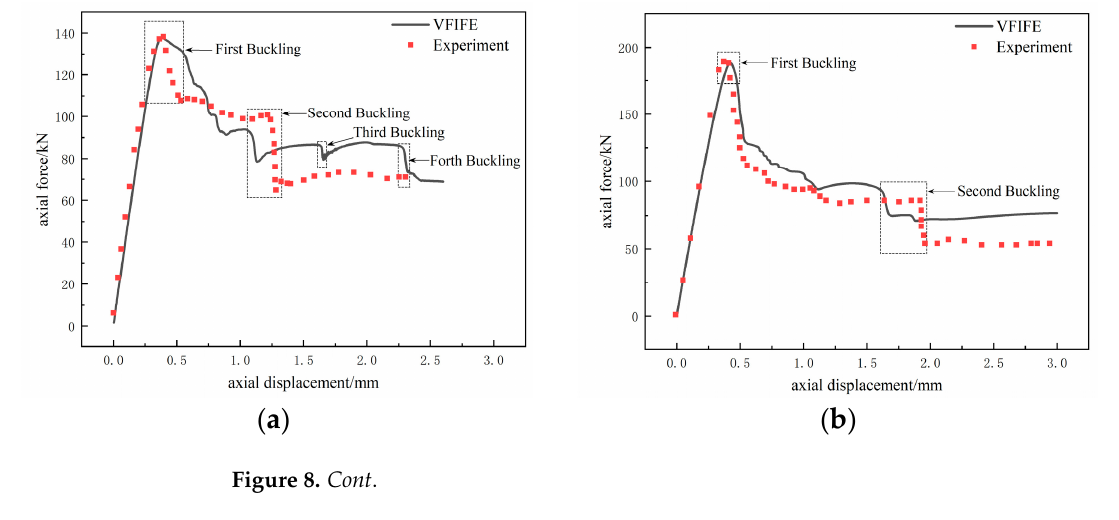
Figure 7. Displacement-load curves under different loading rates.